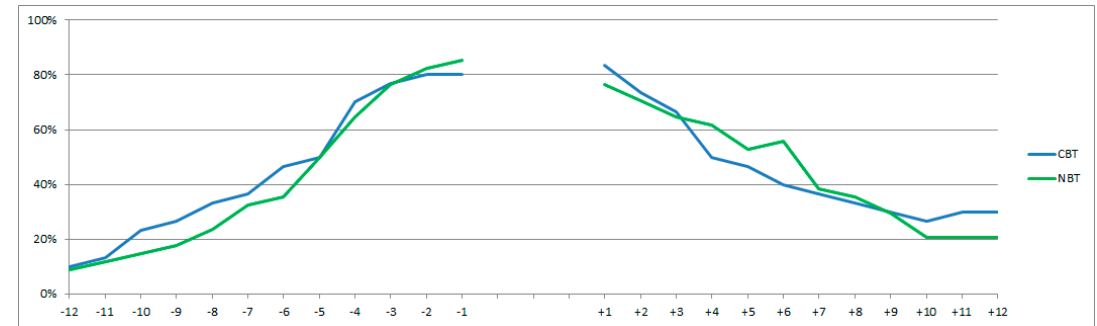
Figure 2. The proportion of participants on sick leave from twelve months prior to twelve months after a treatment. (NBT: n = 34; CBT: n = 30). Note 1. The gap in the graph represents the treatment period; Note 2 . Data from the register: AMRUN; variable; SOC_STATUS_KODE was not available for 2016; therefore, data on three participants in NBT and five participants in CBT are missing. Table 2. Participants’ sick ‐ leave status from the month prior to treatment compared to twelve months after the treatment (NBT: n = 34; CBT: n = 30).